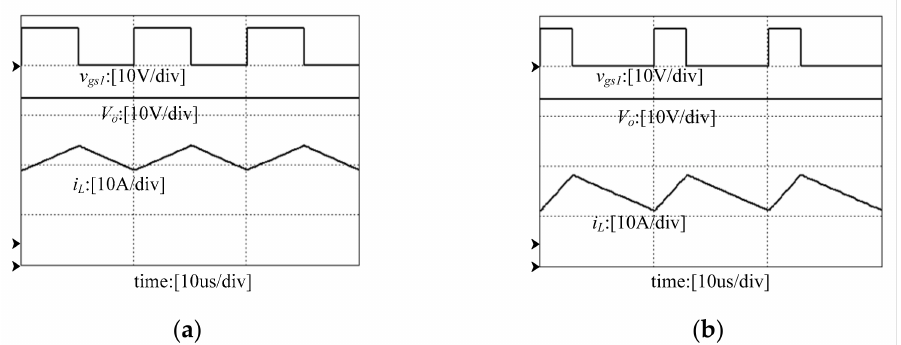
Figure 18. Steady-state simulation results. ( a ) Boost waveform. ( b ) Buck